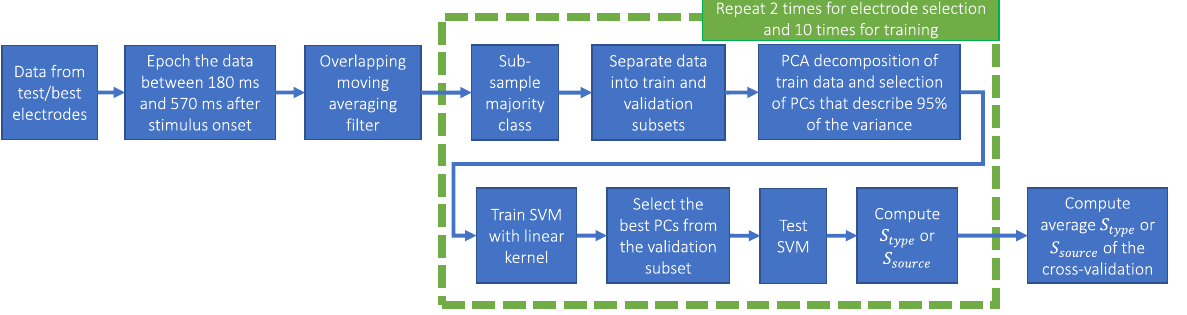
Figure 5. The pipeline for the electrode selection and the training of the SVM